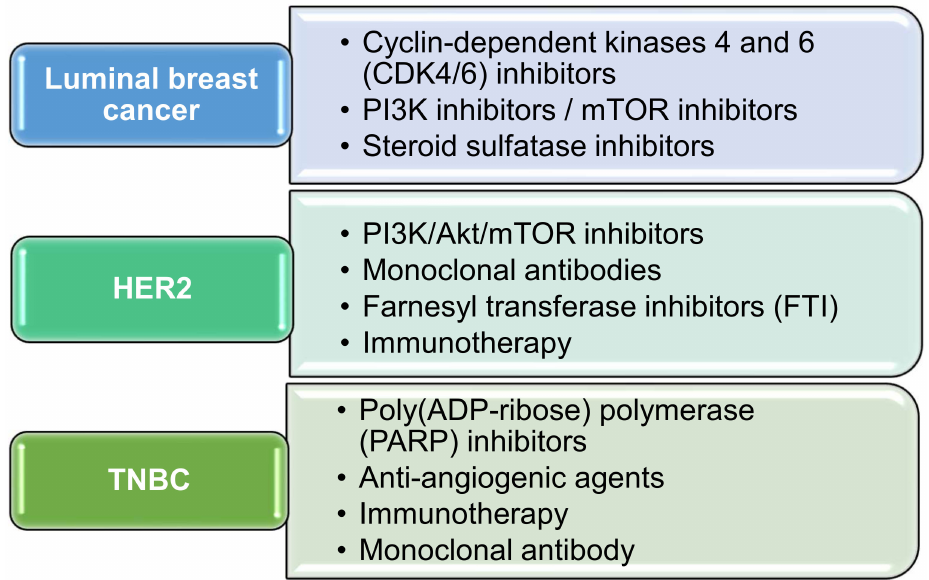
Figure 1. Classification of drugs under targeted therapy based on the type of breast